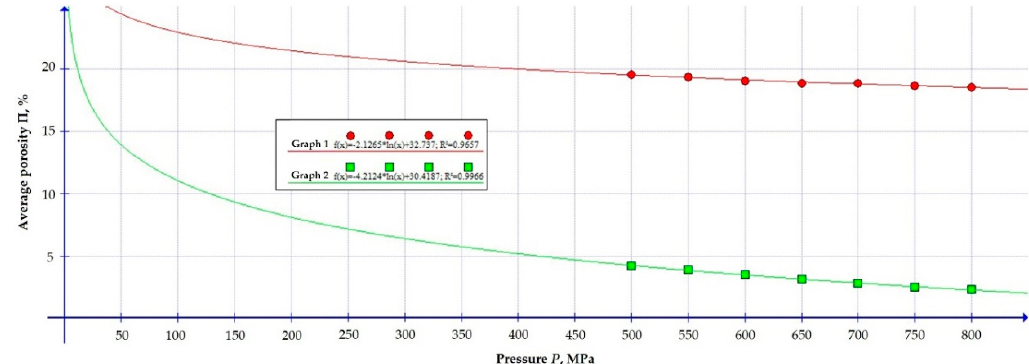
Figure 9. The correlation between applied pressure and average porosity of the samples as thin round parts, where “Graph 1”—obtained by the single axial load; “Graph 2”—obtained by the complex load.